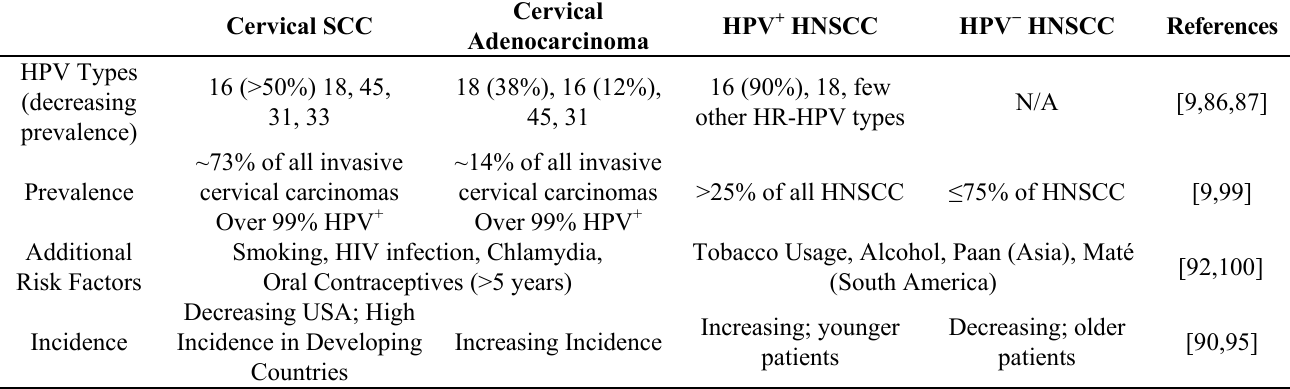
Table 1. Summary of clinical characteristics of cervical and head and neck